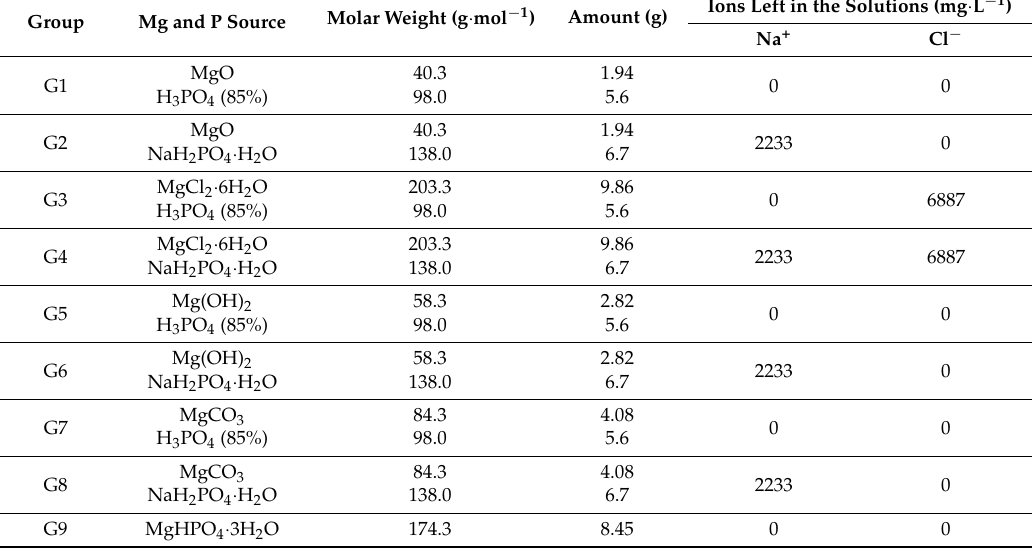
Table 9. Dosage of magnesium and phosphorus sources used in experiment